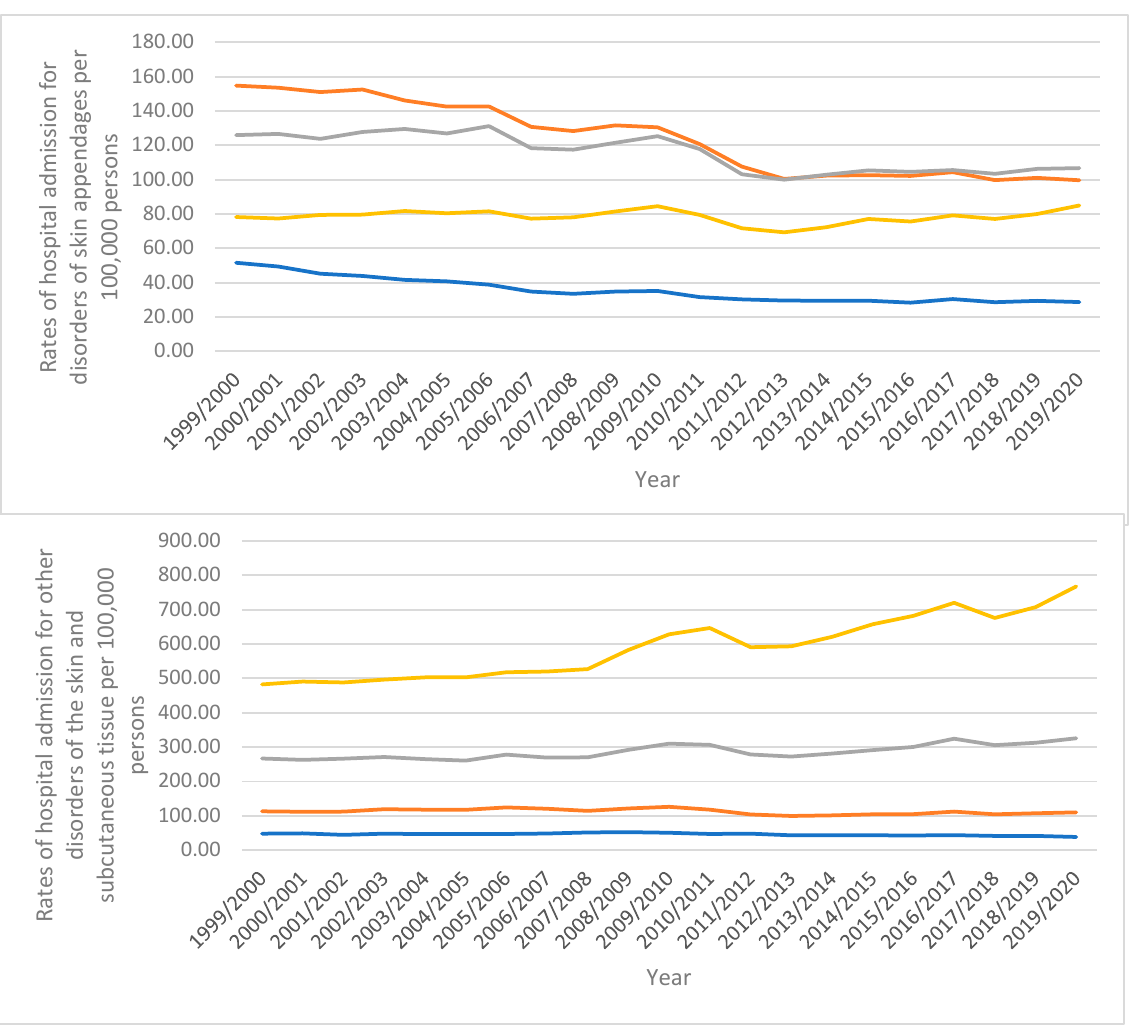
Figure 5. Hospital admission rates stratified by